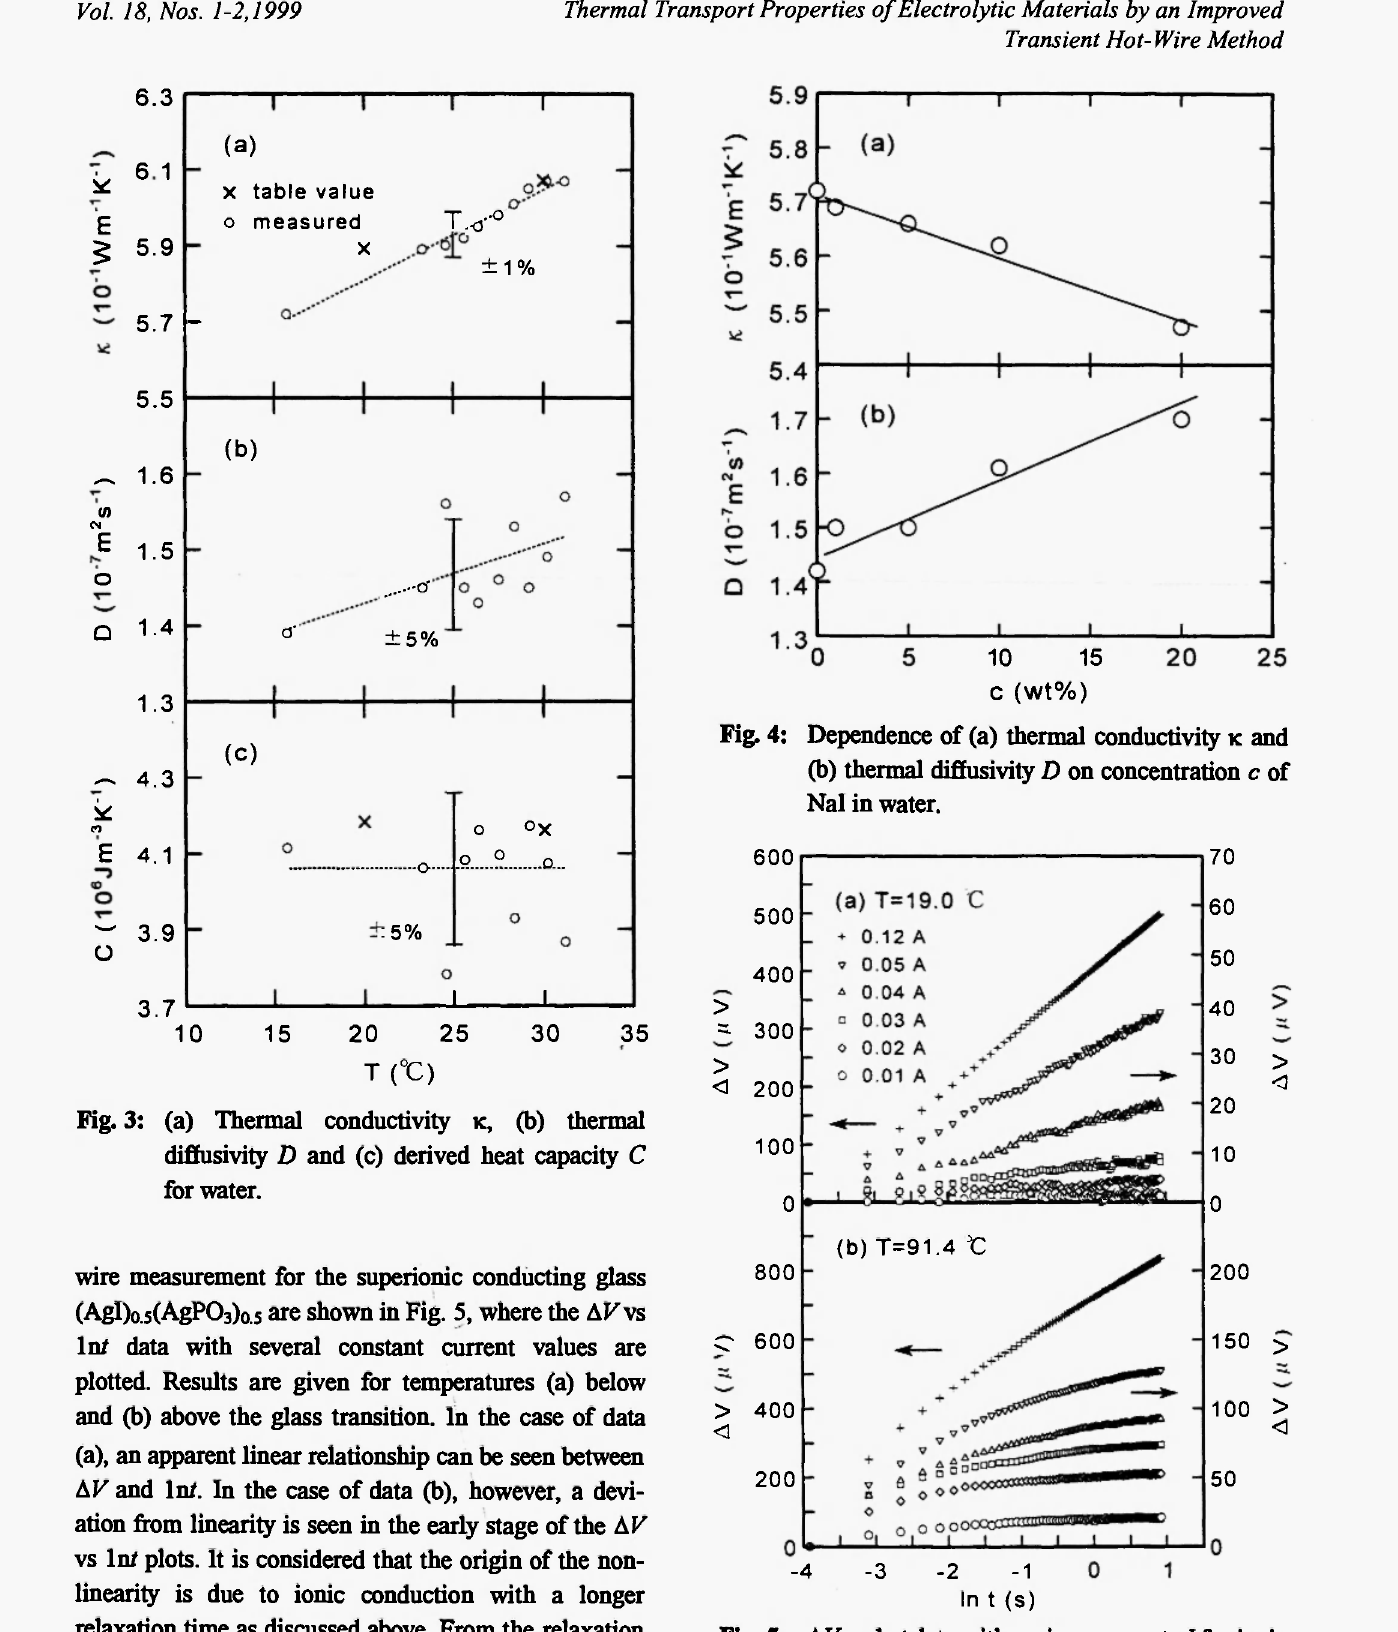
Fig. 5: AFvs In/ data with various currents 1 for ionic conducting glasses (a) below and (b) above the glass transition